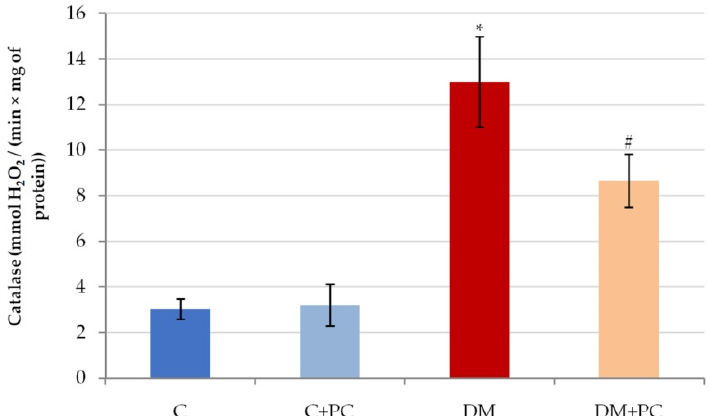
Figure 12. The activity of catalase in plasma of control rats, rats with experimental diabetes mellitus, with and without PC concentrate. C–normal untreated control animals; C + PC–animals that were per os administrated PC concentrate (daily dose of 45 mg/kg bw of polyphenolic complex for 14 days); DM–rats with experimental diabetes mellitus; DM + PC–animals with experimental diabetes mellitus that were per os administrated PC concentrate (daily dose of 45 mg/kg bw of polyphenolic complex for 14 days). *-significant difference compared to control ( p < 0.05); #-significant difference compared to diabetes mellitus ( p < 0.05).